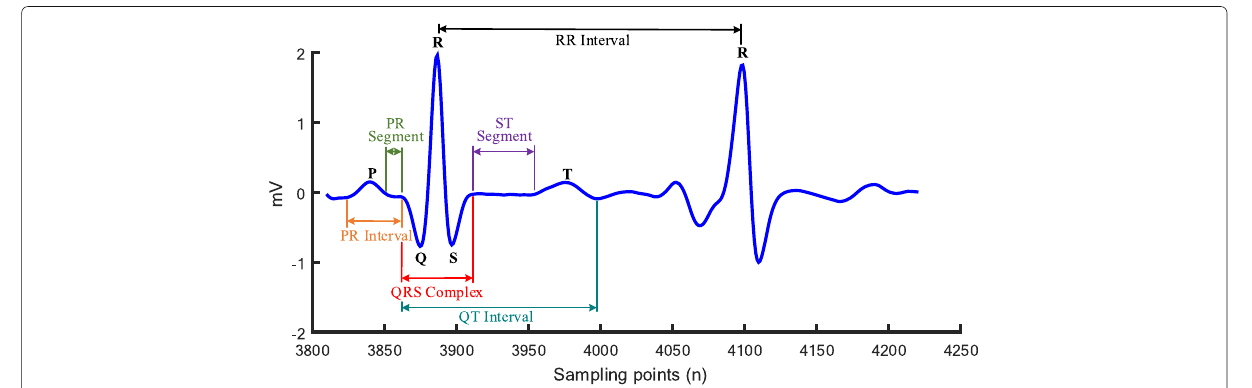
Fig. 1 A typical cardiac cycle (heartbeat) from MIT-BIH arrhythmia database (ECG 100 recording)